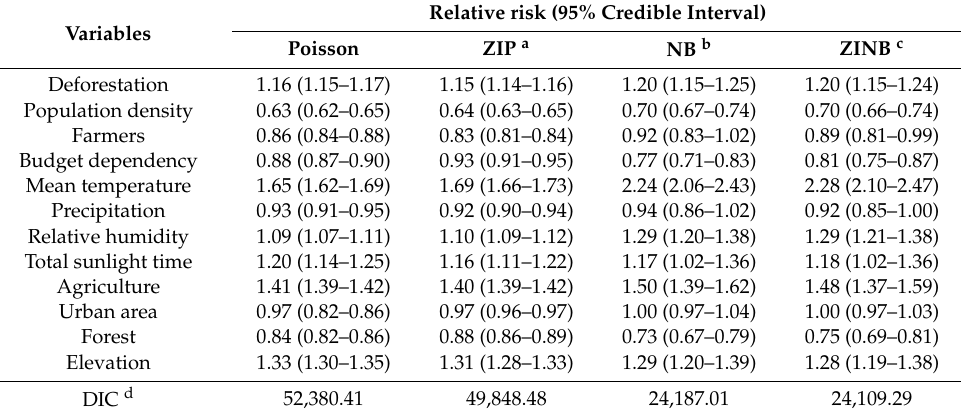
Table 4. Relative risks of scrub typhus by interquartile range increase for each explanatory variable from spatiotemporal models.